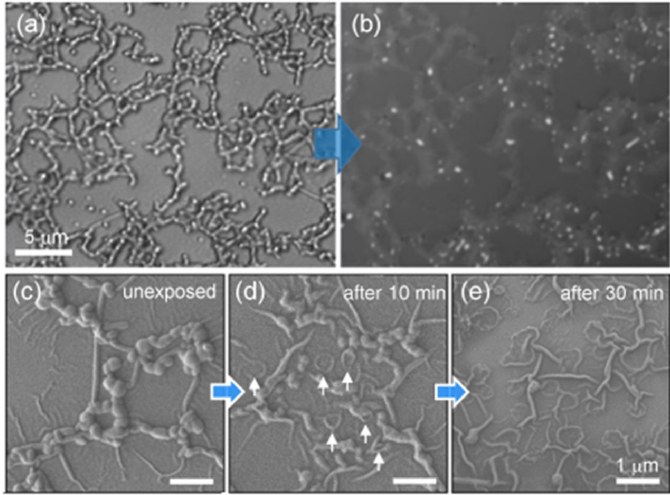
Figure 7. Visible-light-triggered morphological deformation of the samples obtained from the mPEG1000:Bu mixed system ( f mPEG1000 = 80%). LCM images obtained by the ( a ) first and ( b ) second measurements under light illumination ( λ ex = 405 nm). ( c – e ) SEM images showing the light-induced crumpling processes of the interconnected structures under irradiation with light at 436 nm (1–2 mW/cm 2 ). Only crumpled PEG shells remained after sufficient light exposure ( e ). Secondly, to lower the sphere-to-isotropic phase transition rate of SPs in the PEG shells, we chose a low-intensity blue light source (~1–2 mW/cm 2 , 436 nm). The SEM image taken after short-term irradiation with blue light revealed that the center of the particle marked by a white arrow was dented, and its rounded edge still remained (Figure 7c,d). Upon sufficient exposure to blue light for 30 min (Figure 7e), all the particles inside the PEG shell fully melted, and the round shapes disappeared completely. Eventually, only the wrinkled PEG shells remained on the glass